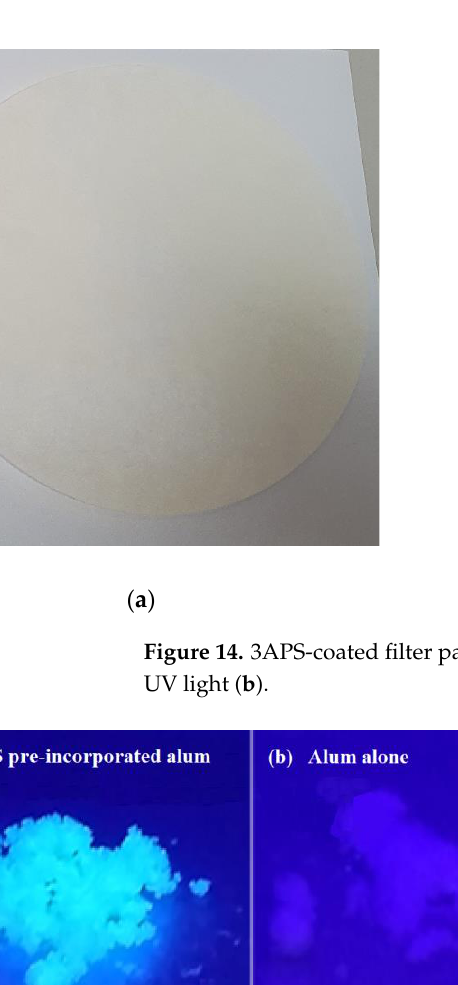
lamp at 365 nm ( b ); two large crystals of alum, the first preincorporated with 3APS during its preparation and the other without 3APS under UV lamp at 365 nm ( c ) .